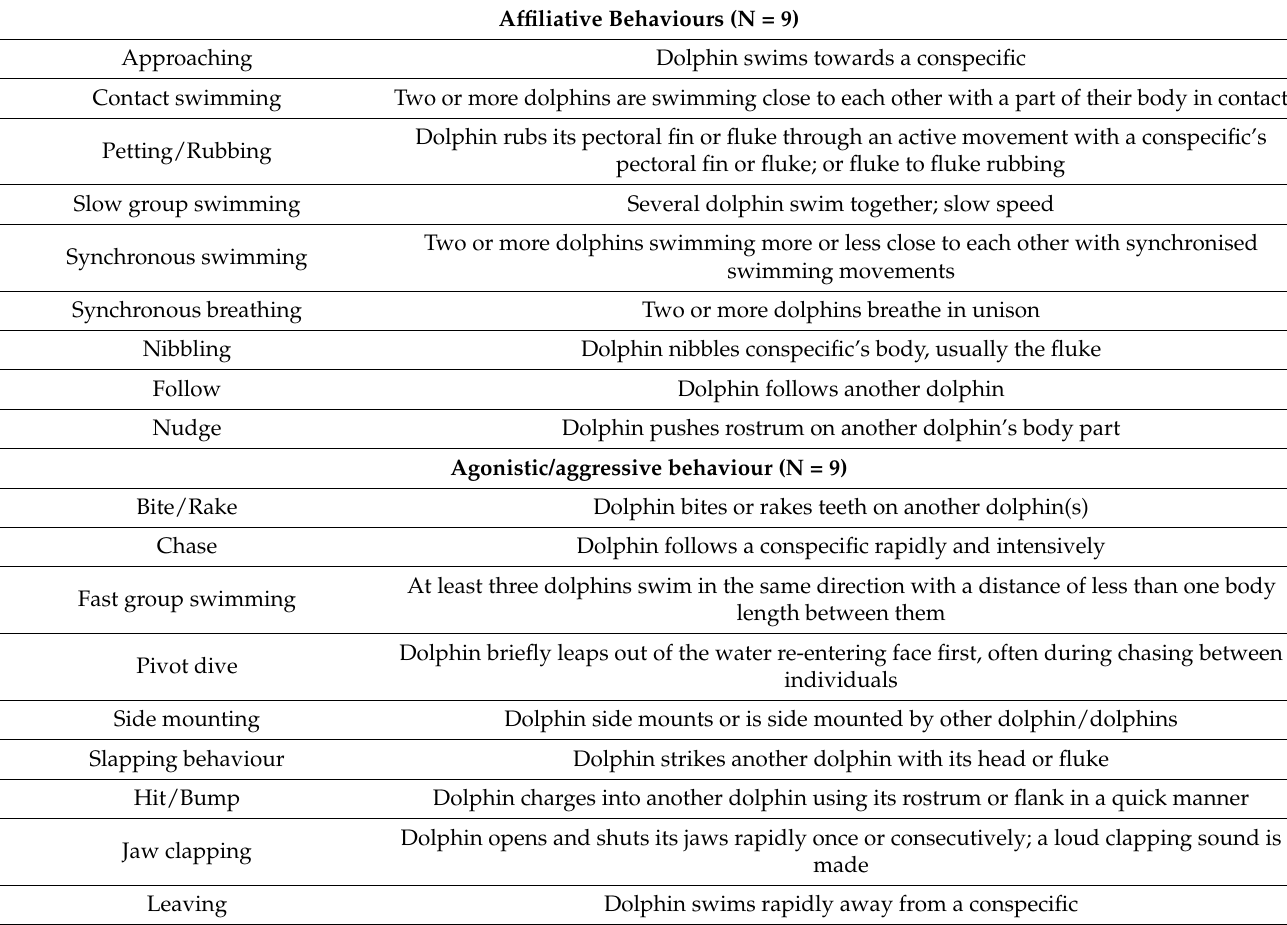
Table 1. Selected behaviours with their corresponding definition grouped into functional